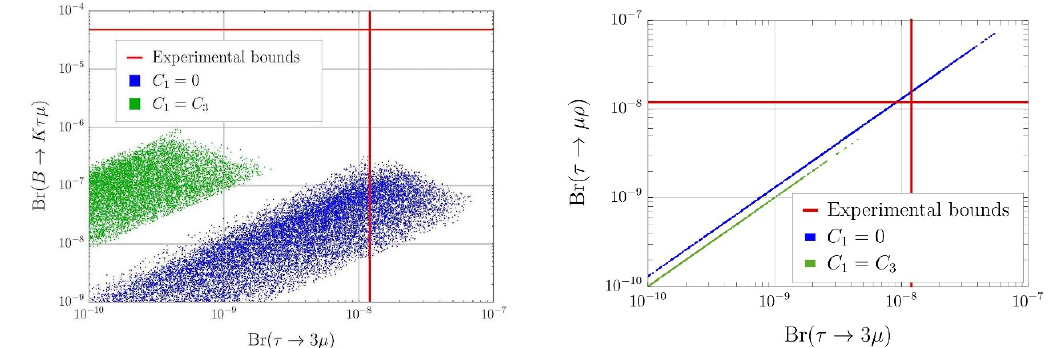
Figure 6 . Left (right) : correlation Br( (cid:28) ! 3 (cid:22) ) vs. Br( B ! K(cid:28)(cid:22) ) (Br( (cid:28) ! 3 (cid:22) ) vs. Br( (cid:28) ! (cid:22)(cid:26) )) within our model, while satisfying all other bounds but R (cid:28)=‘ , for two di(cid:11)erent C 1 vs. C 3 D ( (cid:3) ) con(cid:12)gurations. In the scan the parameters varied in the following ranges: C 1 ; 3 = (cid:3) 2 2 f(cid:0) 4 ; 4 g TeV (cid:0) 2 , (cid:3) 2 f 1 ; 10 g TeV, j (cid:21) e j 2 f 0 ; 0 : 5 g , (cid:21) d 2 f(cid:0) 0 : 2 ; (cid:0) 0 : 01 g . All bounds refer to 2 (cid:27) 23 23